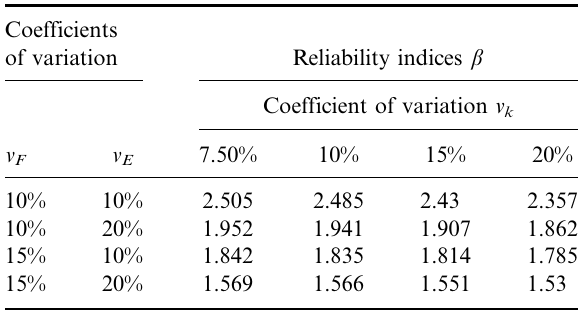
Table 8. Target values of the reliability indices b